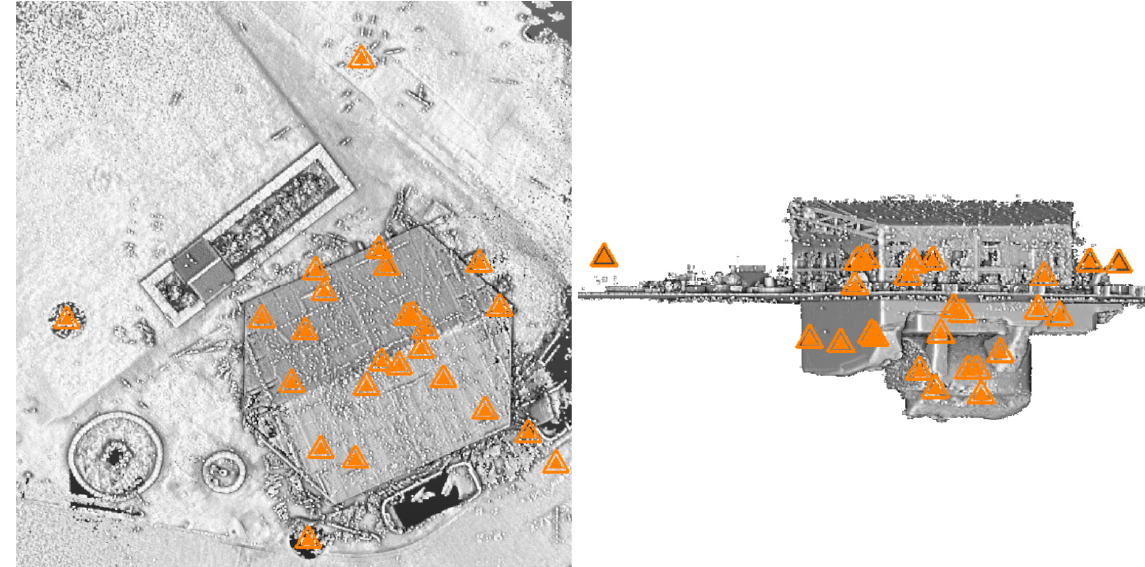
Figure 3. TLS network—top view ( left ), side view ( right ).